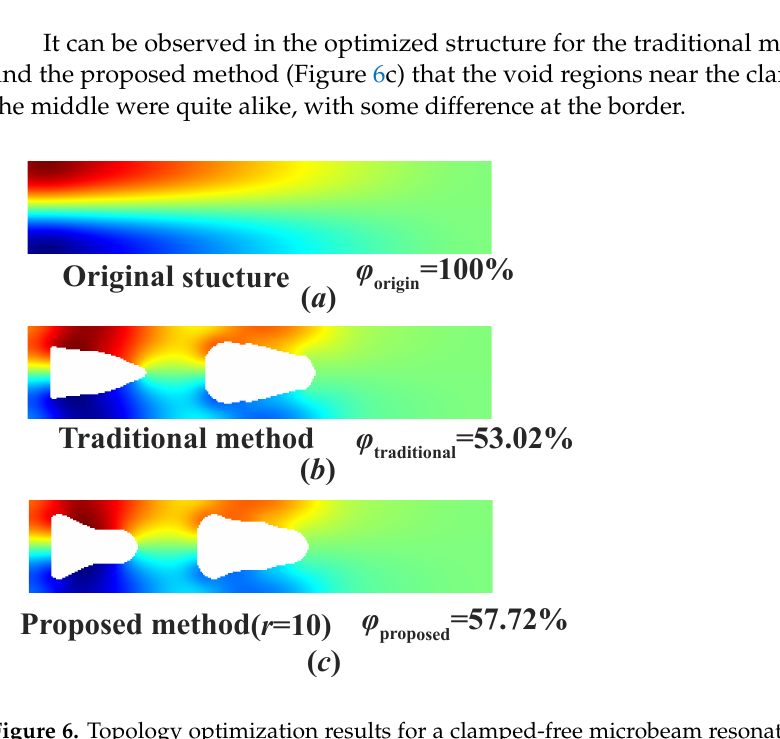
Figure 6. Topology optimization results for a clamped-free microbeam resonator. ( a ) The original structure. ( b ) The optimization result where the traditional subspace method is implemented in the finite element analysis step. ( c ) The optimization result where the proposed method is implemented in the finite element analysis step.